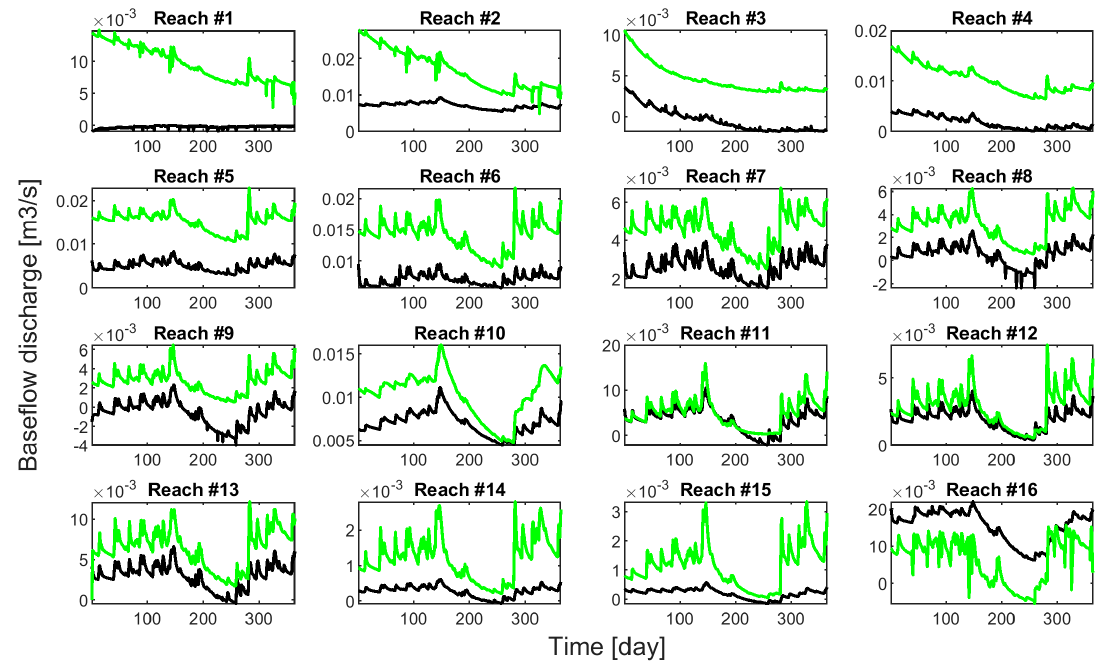
Figure 9. Simulated aquifer-river flow exchange of the river reaches using MIKE SHE (green) and MOBIDIC-MODFLOW (black). Note that positive values represent flow from aquifer to river and negative value represents flow from river to aquifer.